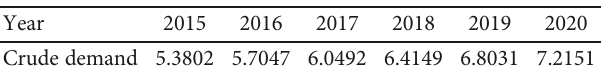
Table 3: The predictive values of China ’ s crude demand (units: 100 million tons) during 2015 –